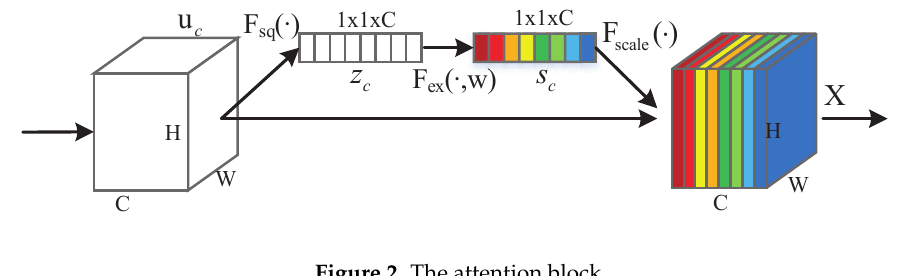
Figure 2. The attention